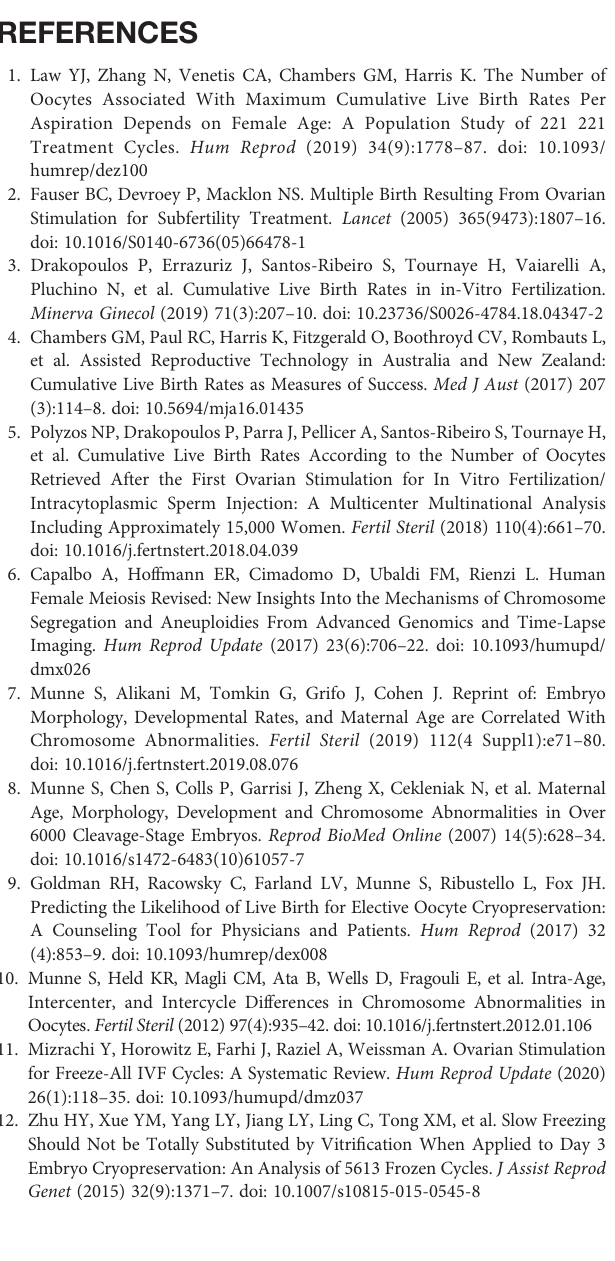
Supplementary Figure 1 | The distribution of patients who did or did not achieve a live birth and the ROC curve of the predictive model. (A) The distribution of patients who did or did not achieve a live birth based on the number of oocytes retrieved. (B) The distribution of patients who did or did not achieve a live birth based on age. (C) The ROC curve of the predictive model; the AUC value of ROC curve is